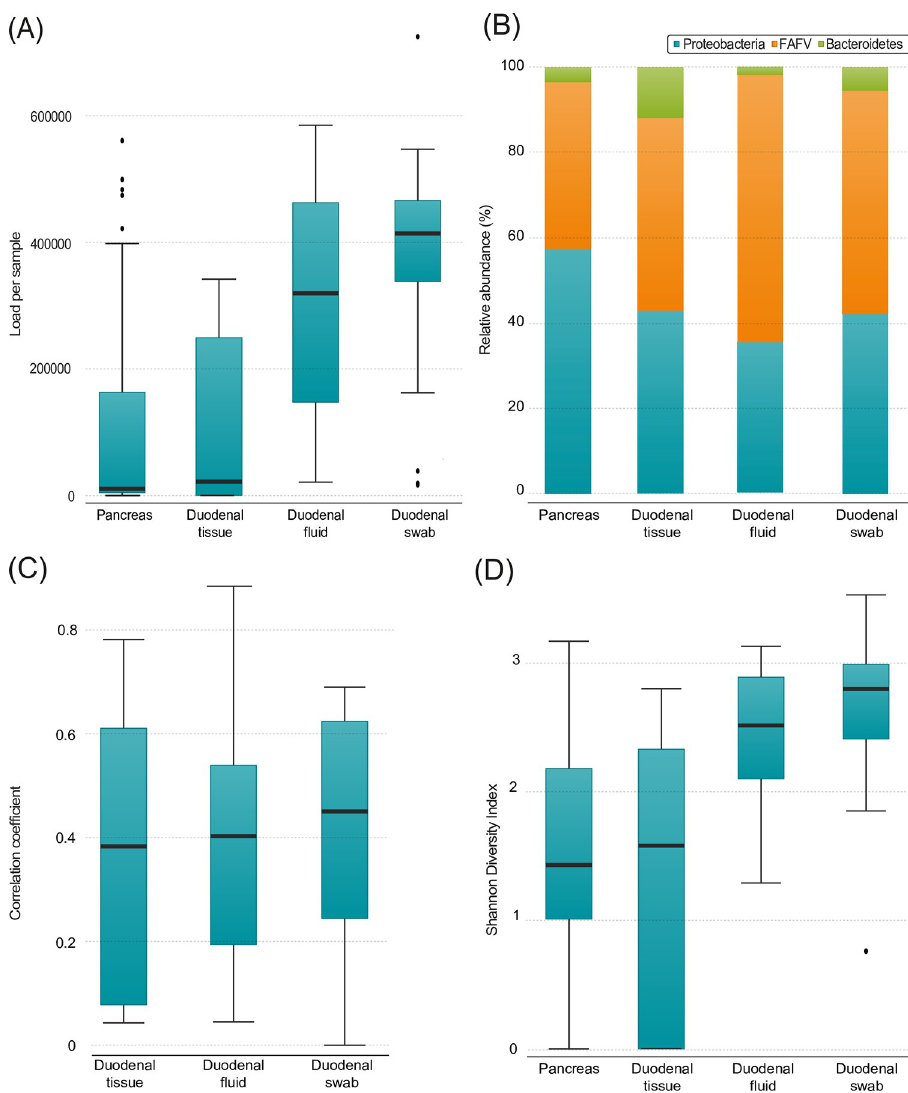
Fig 5. (A) Total load per sample (duodenal swab (n = 21) vs pancreatic tissue (n = 51) p = < 0.001, duodenal swab (n = 21) vs duodenal tissue (n = 11) p = 0.002, pancreatic tissue (n = 51) vs duodenal fluid (n = 22) p < 0.001, duodenal tissue (n = 11) vs duodenal fluid p = 0.014) ( B) Relative abundance of phyla per sample. Pancreatic tissue (n = 51), duodenal tissue (n = 11), duodenal fluid (n = 22), duodenal swab (n = 21) ( C) Correlation coefficient between the pancreatic biopsies and denoted material within the same patient. Duodenal tissue (n = 11), duodenal fluid (n = 22), duodenal swab (n = 21) (D) Shannon diversity index per sample (duodenal swab (n = 21) vs duodenal tissue (n = 11) p = 0.004, duodenal swab (n = 21) vs pancreatic tissue (n = 49) p < 0.001, duodenal fluid (n = 22) vs duodenal tissue (n = 11) p = 0.043, duodenal fluid vs pancreatic tissue (n = 49) p = 0.001). Boxplots: Black bar denotes median, box denotes the interquartile range, whiskers indicate the range of values that are outside of the interquartile range. Outliers are defined as > 1.5 times the size of the interquartile range and presented as a black dot. https://doi.org/10.1371/journal.pone.0278377.g005 2.06 vs pancreatic biopsy 1.74, p = 0.007) and partly by to Proteobacteria (duodenal swab 2.03 vs pancreatic biopsy 1.67, p = 0.006; duodenal fluid 1.76 vs pancreatic biopsy 1.67, p = 0.004). In the paired samples, the FAFV was also significantly different between all duodenal materials and the pancreatic biopsy (duodenal swab 2.17 vs pancreatic biopsy1.04, p = 0.032; duodenal fluid 1.91 vs pancreatic biopsy 1.15, p = 0.035; duodenal tissue 1.71 pancreatic biopsy 0,71, p = 0.05. For the complete overview of the paired analysis, see Appendix I. The lower diversity